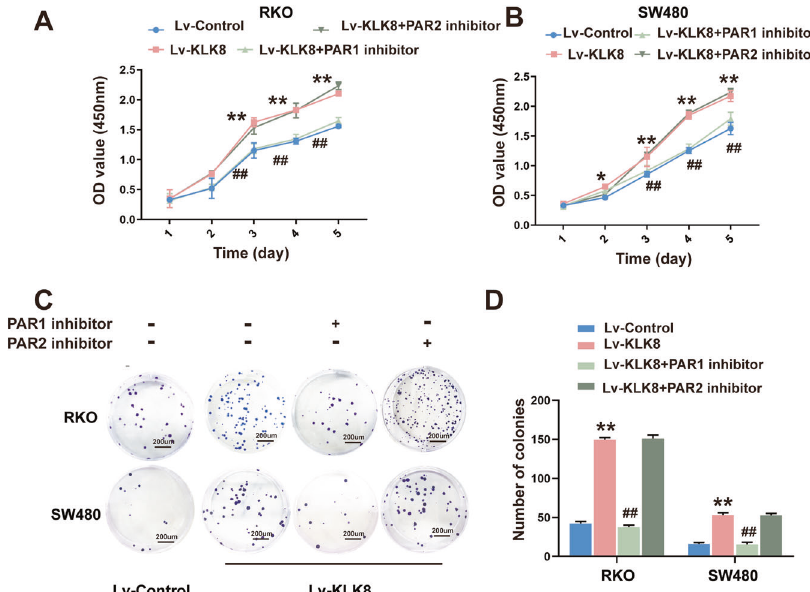
Fig. 6 PAR1 inhibition suppresses the proliferation in colorectal cancer cells induced by KLK8 in vitro. KLK8-overexpressed RKO and SW480 cells were treated with PAR1 antagonist SCH79797(100 μ M) or PAR2 antagonist FSLLRY-NH2 (150 nM). A , B CCK8 showed the proliferation rate of CRC cells. C Colony formation assay for the proliferative ability of Lv-control or Lv-KLK8-transfected CRC cells treatment with PAR1 antagonist SCH79797 or PAR2 antagonist FSLLRY-NH2. D Histogram represents the statistical analysis of ( C ). All of the data are presented as the mean ± SEM from three independent experiments. * P < 0.05, ** P < 0.01 vs. Lv-control; 0.05, ## P < 0.01 vs.